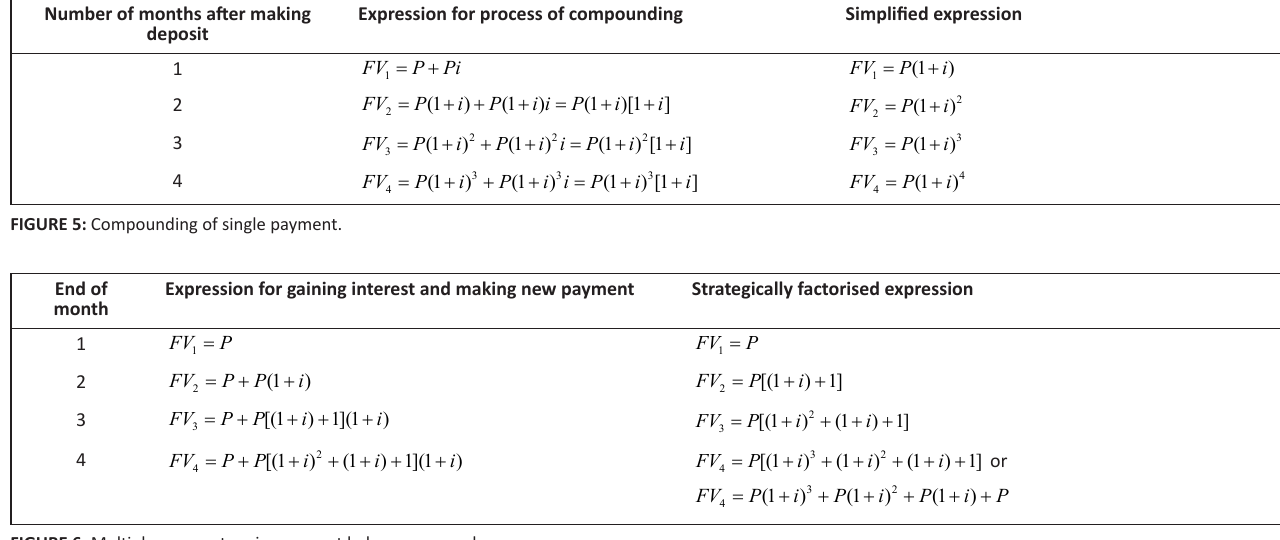
FIGURE 6: Multiple payments using account balance approach.